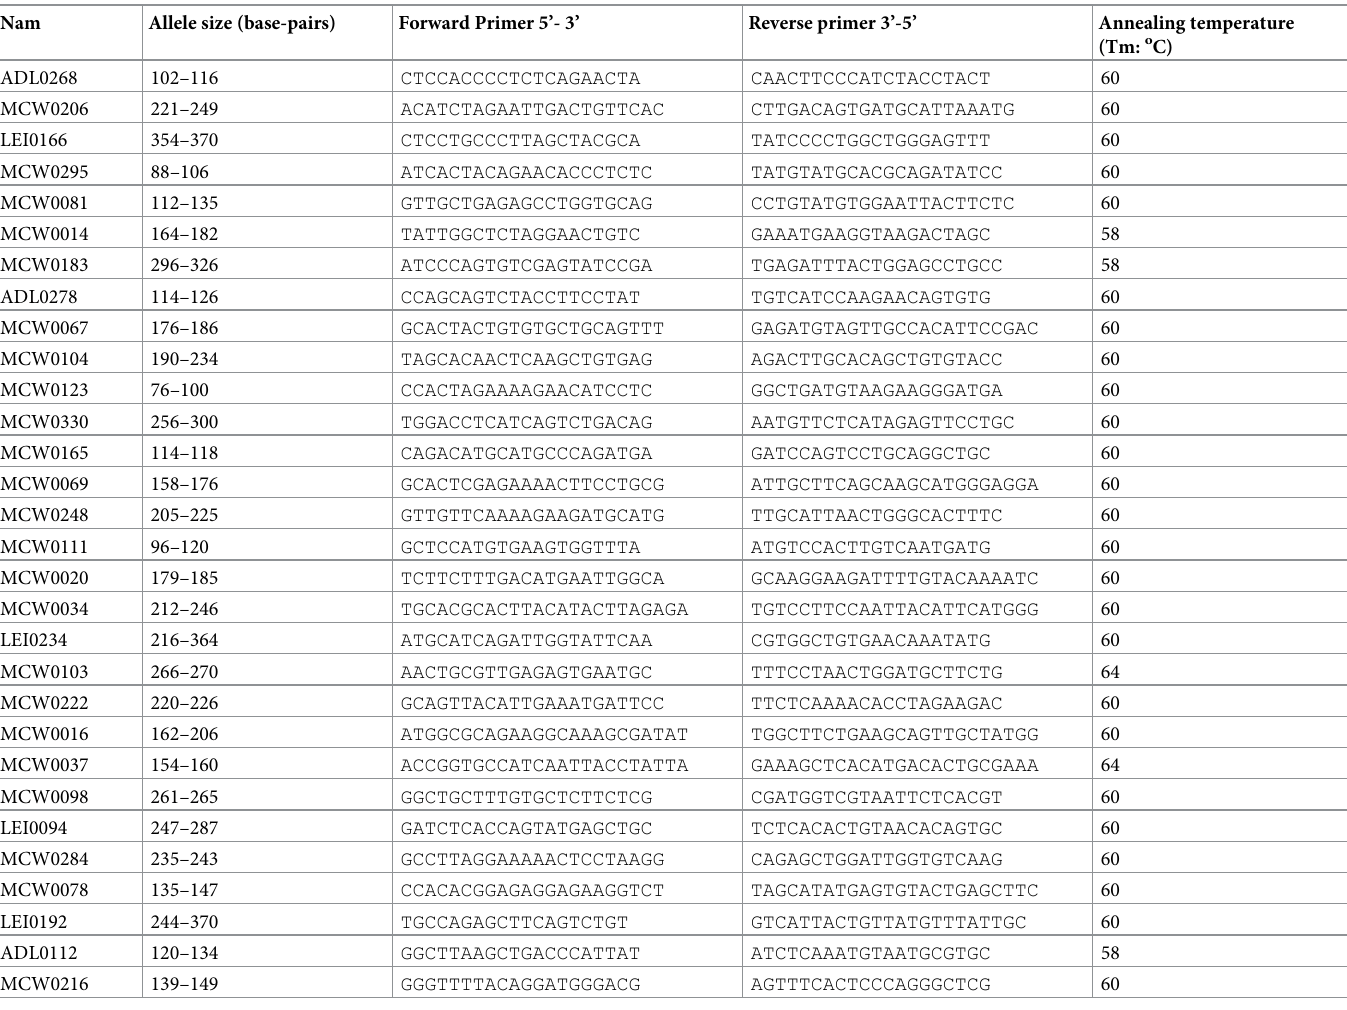
Table 1. Sequences and physical information of 28 SSR markers used for PCR